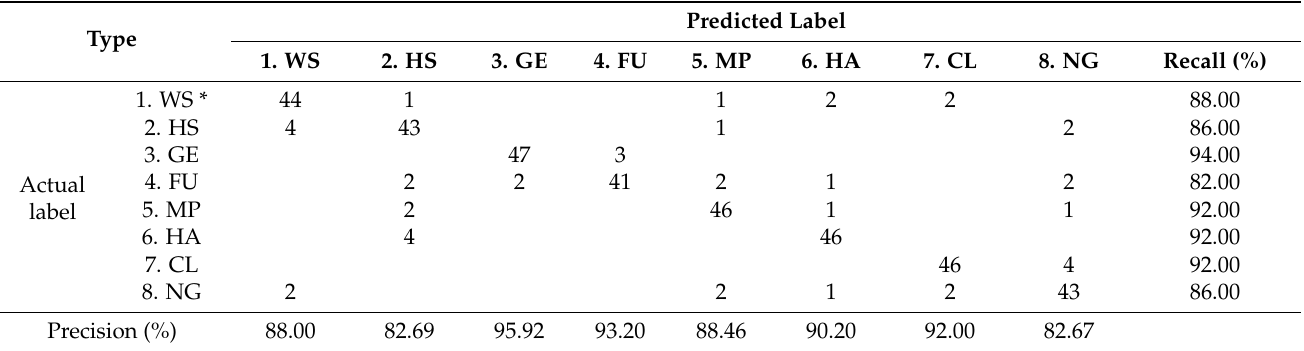
Table 9. Confusion matrix of the eight types of geothermal surface manifestations for the GoogLeNet model on the testing subset.